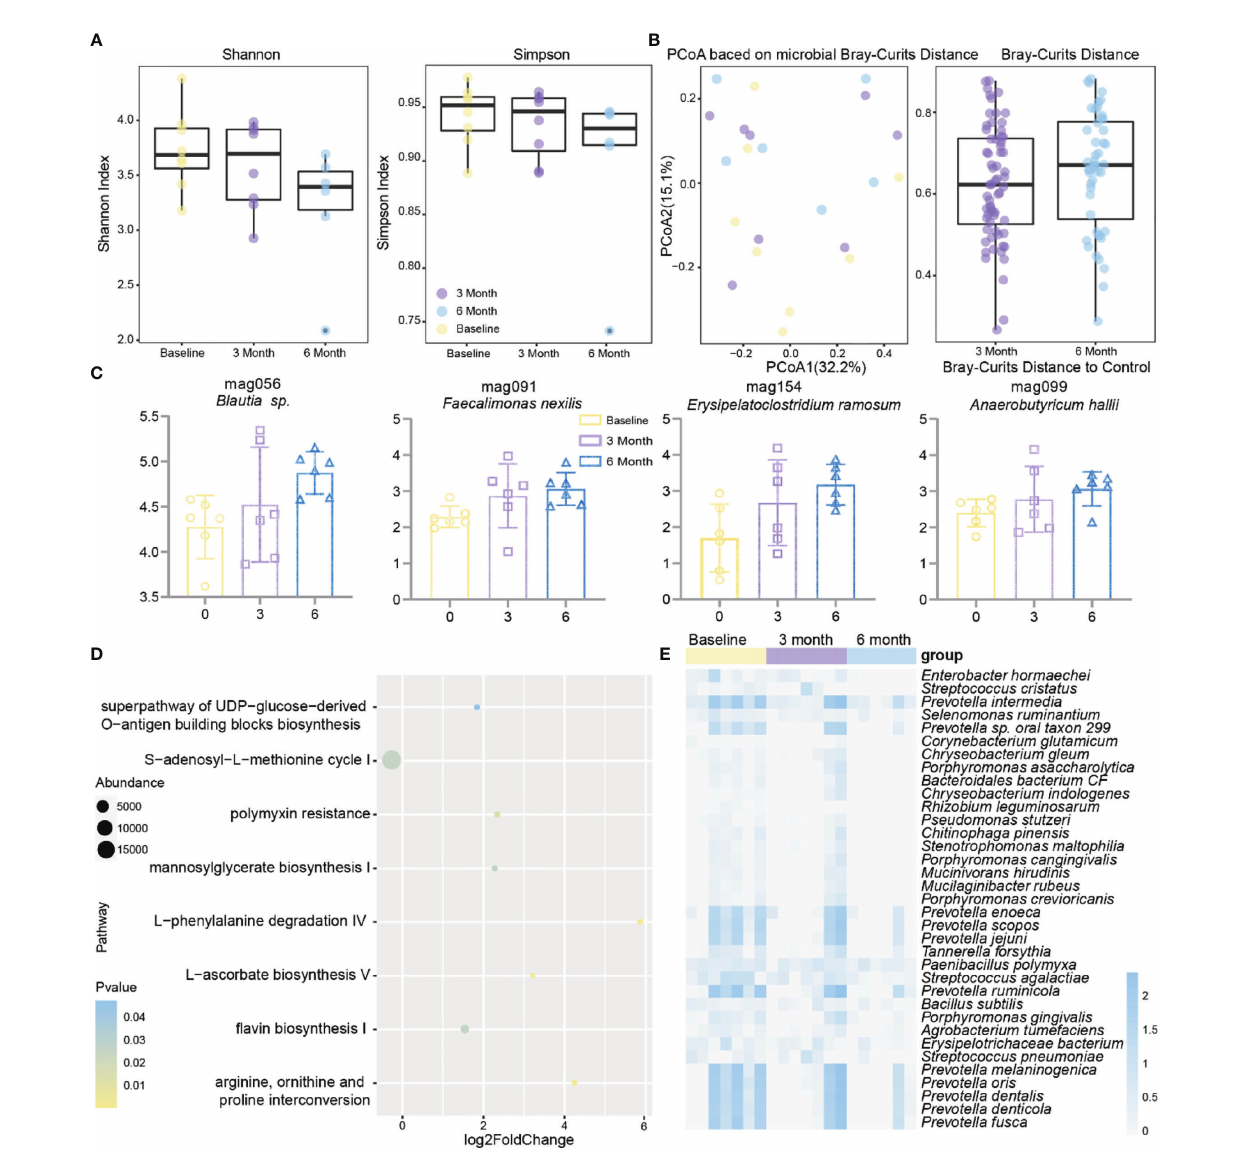
FIGURE 2 | Effect of methimazole alone on the intestinal microbiota of patients with GD. (A) The effects of mebendazole alone on intestinal microbiota a diversity, including shannon and Simpson index, the same color points represent the volunteers at different time points. (B) Principal coordinates analysis (PCoA) based on Bray-Curtis distances for metagenomic species, with points of the same color representing the volunteer at different time points. (C) MAGs with signi fi cant differences from baseline at 6 months of treatment. (D) Gut microbial metabolic pathways that produced signi fi cant differences from methimazole treatment at 6 months of treatment at baseline. (E) Strains with signi fi cant differences from baseline at 6 months of